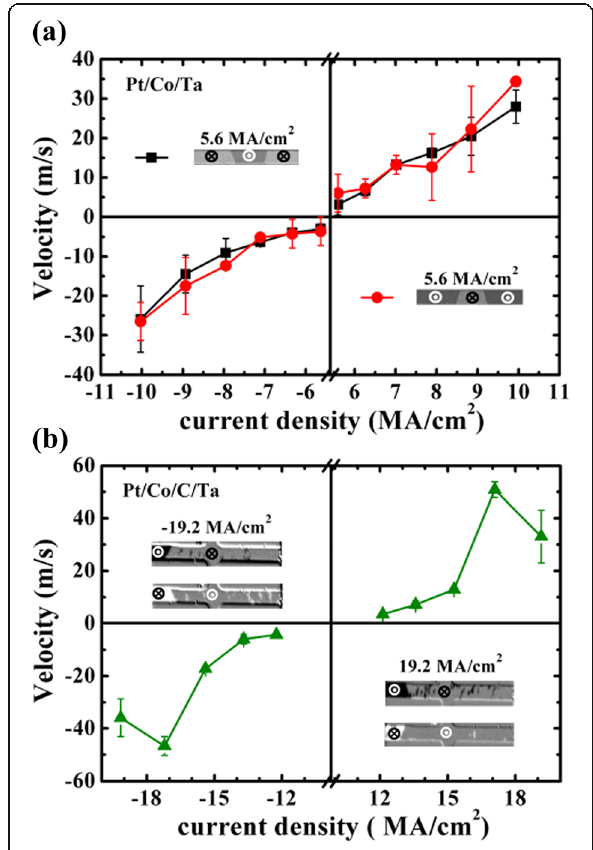
Fig. 2 DW velocity against current density for Pt/Co/Ta ( a ) and Pt/ Co/C/Ta ( b ). The insets in a and b represent the snapshots of the domain shape at the representative current